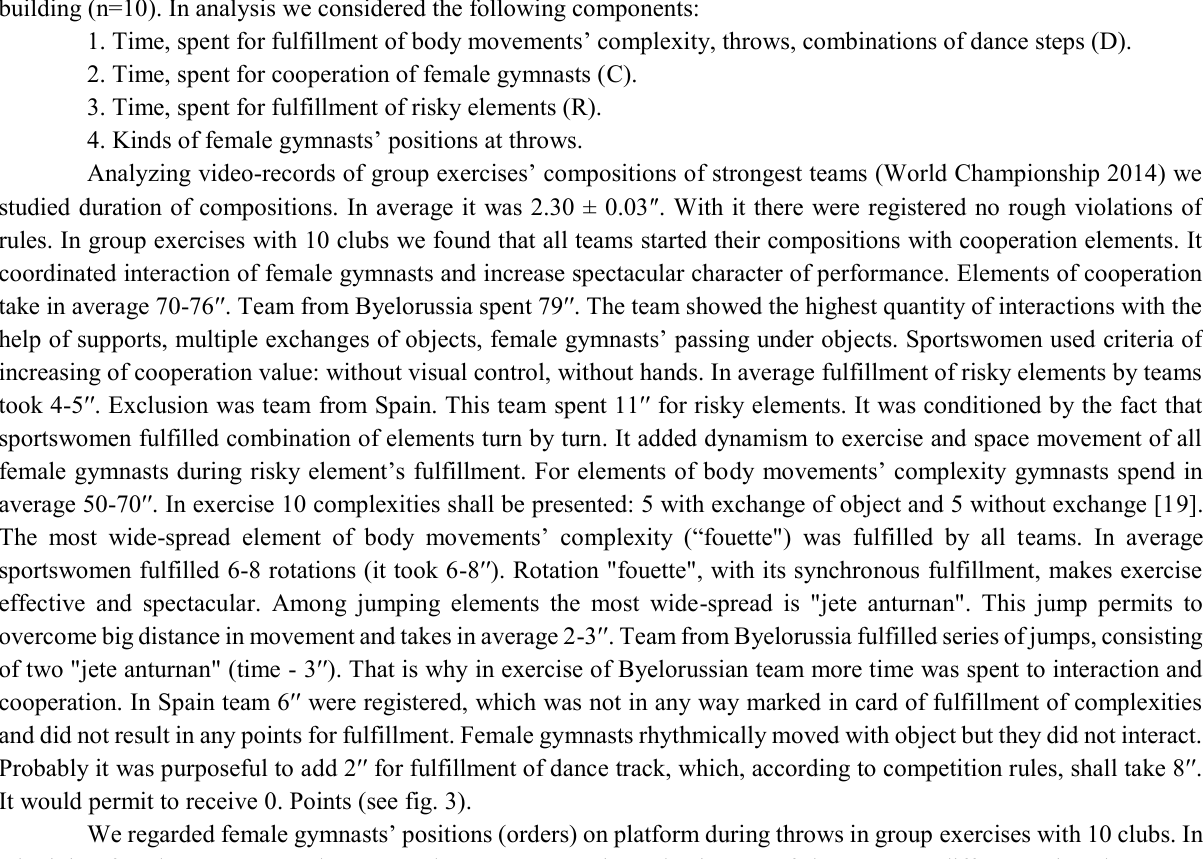
Fig.2. Kinds of female gymnasts’ movements on platform in competition compositions with